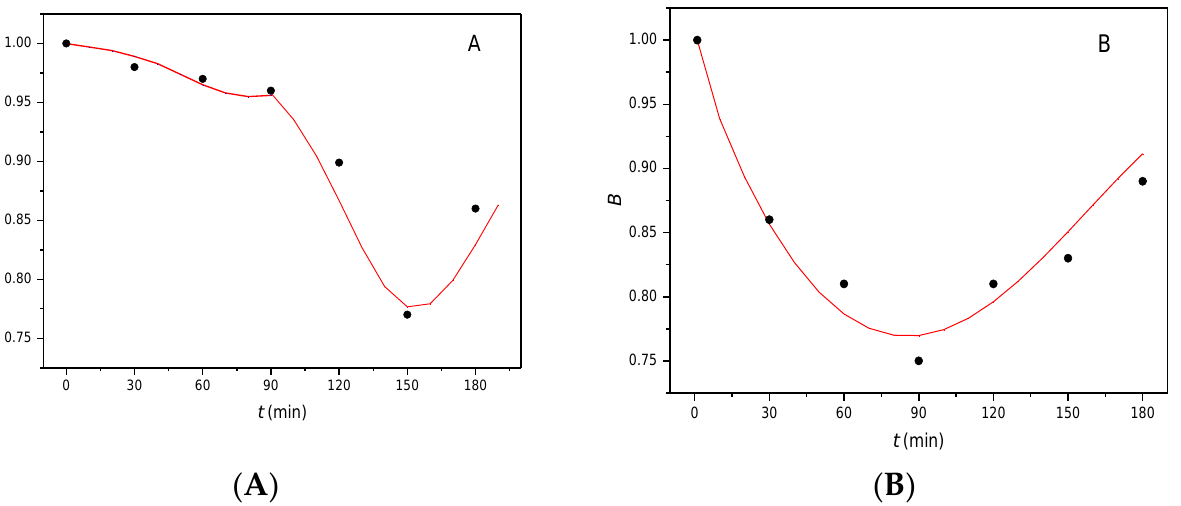
Figure 5. Comparison of the B ( t ) curves obtained for the interaction of hormone αE2 with ( A ) mouse sperm [7] and ( B ) rat sperm, dose concentration 200 µg/L; the experimentally obtained points are depicted as black circles.